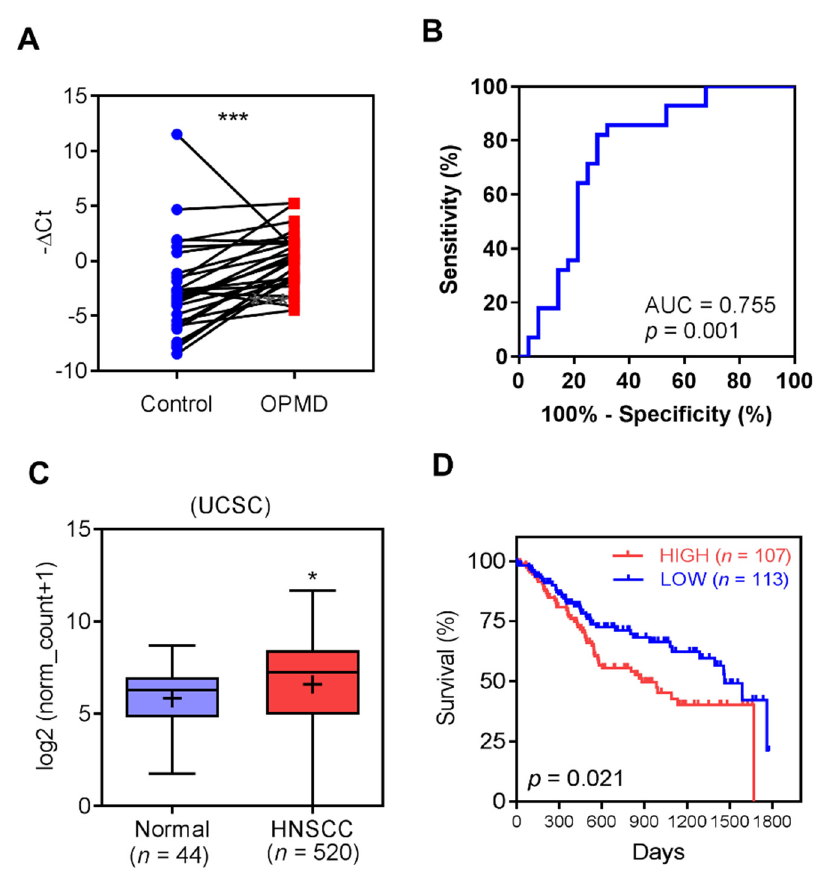
Figure 1. MIR31HG expression in brushed OPMD samples and the HNSCC dataset. ( A ) Before- after-blot demonstrating the increase in the − ∆ Ct values for MIR31HG obtained from samples of normal mucosa compared to those obtained from OPMD. ( B ) ROC curve of the − ∆ Ct of MIR31HG showing an accuracy of 0.76 when separating OPMD samples from control samples. ( C ) Increased MIR31HG expression in HNSCC tumors relative to normal tissues extracted from the TCGA dataset. ( D ) Kaplan–Meier survival analysis. This indicates that HNSCCs showing increased MIR31HG expression in the highest quadrant exhibits a worse prognosis than those with lower expression in the lowest quadrant. *, p < 0.05; ***, p < 0.001.